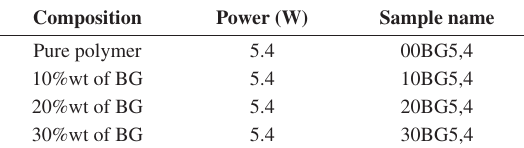
Table 1. Compositions and laser power for sample processing.